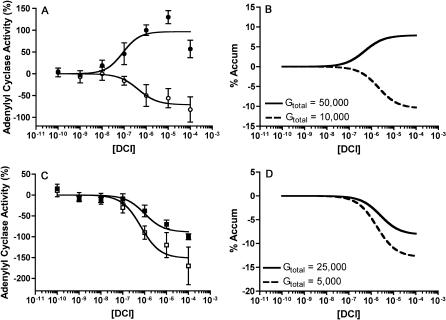
Protean Agonism in the β2-Adrenergic Receptor System(A) Dichloroisoproterenol (DCI) effect on adenylyl cyclase activity in Sf9 cells. DCI was found to be both a partial agonist (•) and an inverse agonist (○) in this study. Data replotted from Chidiac et al. (1996).(B) Simulations of DCI activation of GαGTP. Protean agonism properties of DCI caused by 5-fold difference in G protein concentration.(C) After desensitizing treatment with isopreterenol, DCI was found to inhibit adenylyl cyclase activity in membranes where previously positive agonism was seen (•). This treatment further decreased activity of adenylyl cyclase in membranes where inverse agonism was observed (○). Data replotted from Chidiac et al. (1996).(D) Desensitization treatment by isopreterenol is simulated by decreasing G protein (Gtotal) by 50%. Parameter values are equal to those listed in Figure 4 except when otherwise noted. Rtotal = 4,000/cell, α = 0.5, δ = 5. Simulated dose response curves (B,D) measuring the percent accumulation of GαGTP (%Accum) were calculated according to Equation 2 as described in Methods.